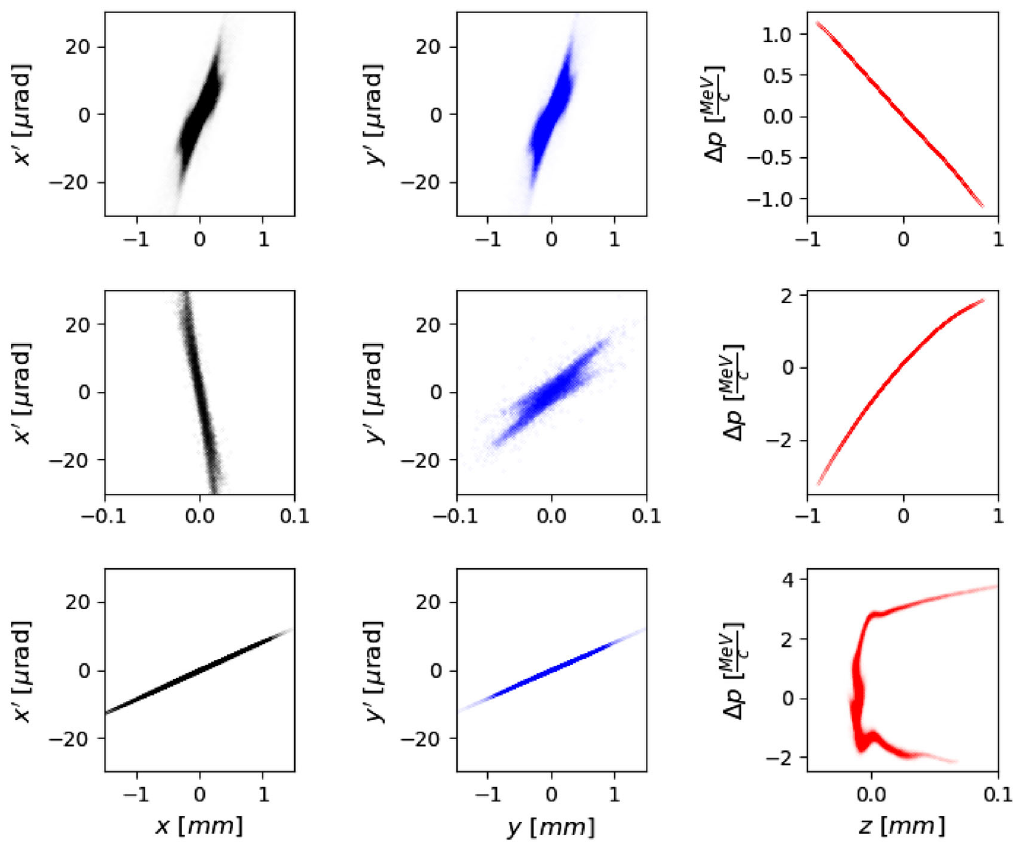
16. First row: ð x ; x 0 Þ , ð y ; y 0 Þ and ð z ; Δ p Þ bunchphase spaces at the injector exit, ∼ 130 MeV. Second row: ð x ; x 0 Þ , ð y ; y 0 Þ and ð z ; Δ p Þ bunch phase spaces at the BAC entrance, ∼ 1 . 6 GeV. Third row: ð x ; x 0 Þ , ð y ; y 0 Þ and ð z ; Δ p Þ bunch phase spaces at L2 entrance, ∼ 3 . 0